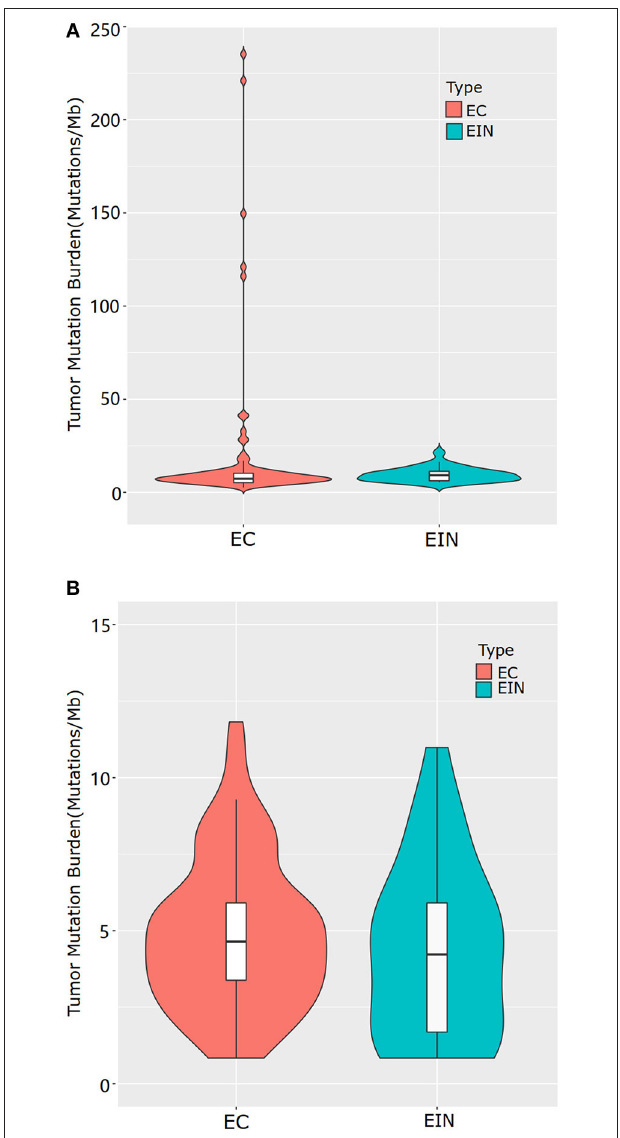
FIGURE 1 | Tumor mutational burden levels of EEC and EIN. (A) comparison of TMB which included all samples of EEC. (B) comparison of TMB which excluded samples of EEC with mutations in genes involved in DNA damage repair pathway. EIN, endometrial intraepithelial neoplasia; EEC, endometrioid endometrial